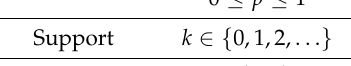
Table 1. Parameters of negative binomial distributions.